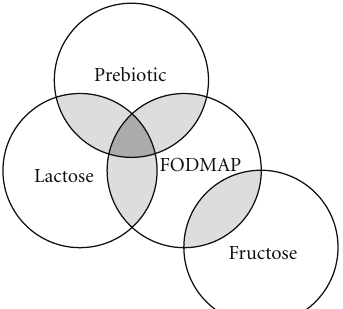
Figure 1: This Venn diagram shows the relationship between FODMAP, comprises of fructose, oligosaccharides, disaccharides, monosaccharides, and polyols. The central diet includes the major- ity of carbohydrates which are hypothesized to be malfermented by lower intestinal bacteria and therefore leading to excess production of gas and short-chain fatty acids with induction of symptoms. Thus, FODMAP includes all prebiotics in which lactose is included also as a restricted probiotic in lactose maldigesters. It is the hypothetical benefits of either withdrawal from diet or adapting to the prebiotic components of this diet that potentially forms a scientific conundrum in